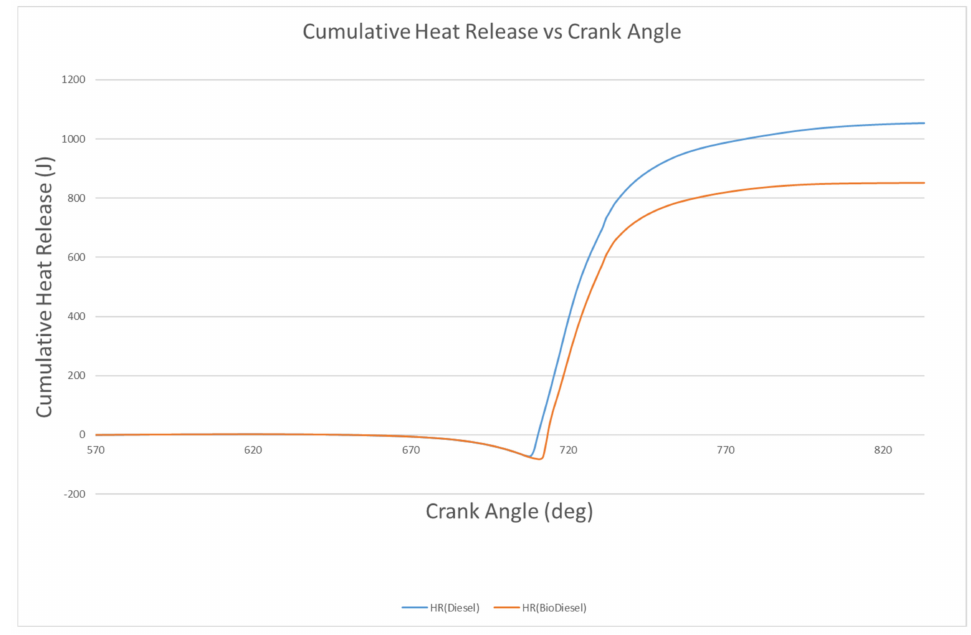
Figure 13. Cumulative heat release vs. crank angle.